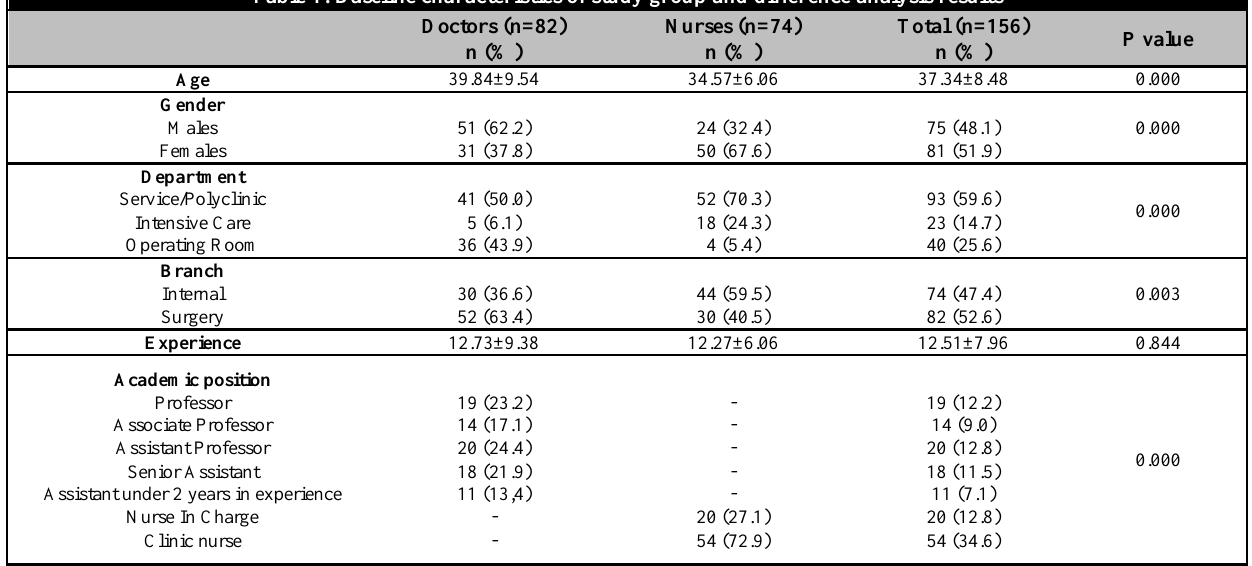
Table 1: Baseline characteristics of study group and difference analysis results Doctors